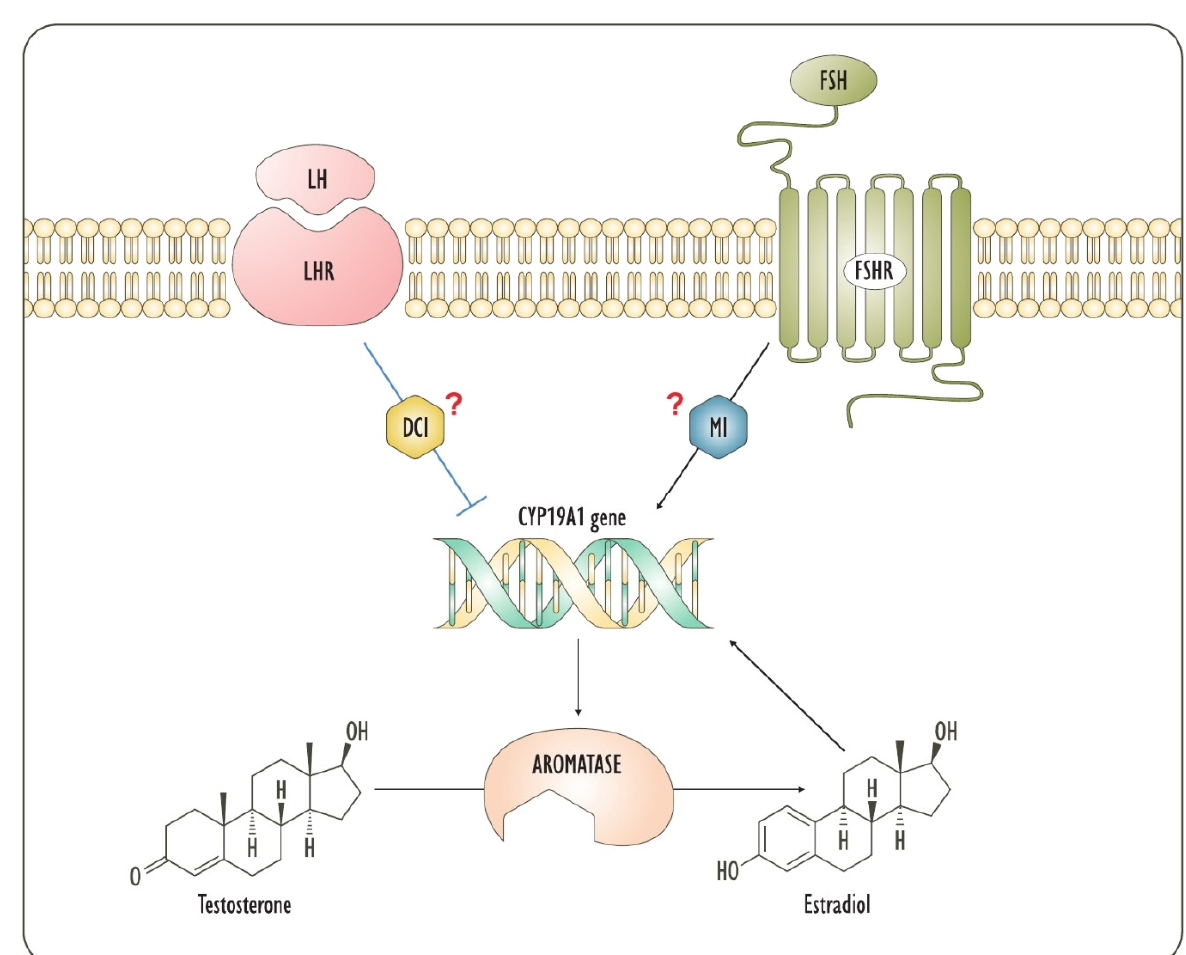
Figure 2. The figure depicts the regulation by LH and FSH of aromatase expression. Gonadotropins are involved in ovarian steroidogenesis through their intracellular mediators, which are strongly supposed to be inositols. Actually, LH signal involves principally theca cells, while FSH primarily acts on granulosa. DCI: D-chiro-inositol; FSH: Follicle-Stimulating Hormone; FSHR: Follicle-Stimulating Hormone Receptor; LH: Luteinizing Hormone; LHR: Luteinizing Hormone Receptor; MI: Myo-inositol.